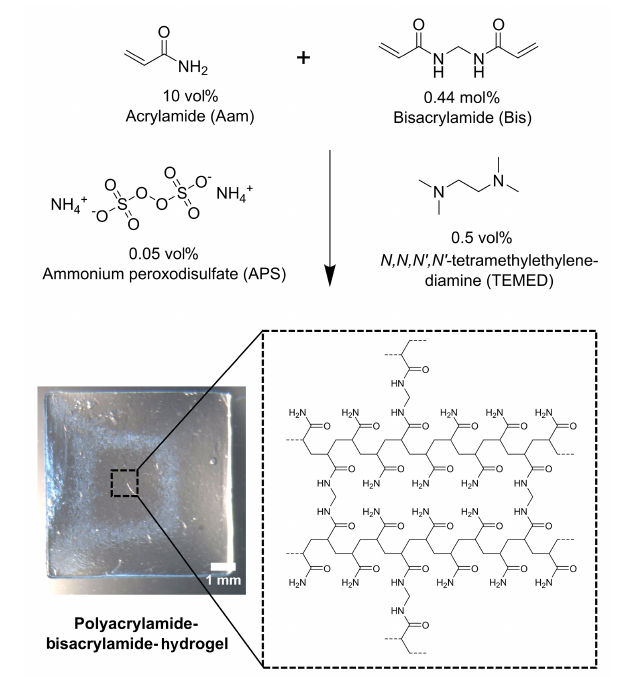
Figure 1. Polymerization of ethanol-sensitive polyacrylamide- bisacrylamide hydrogels.